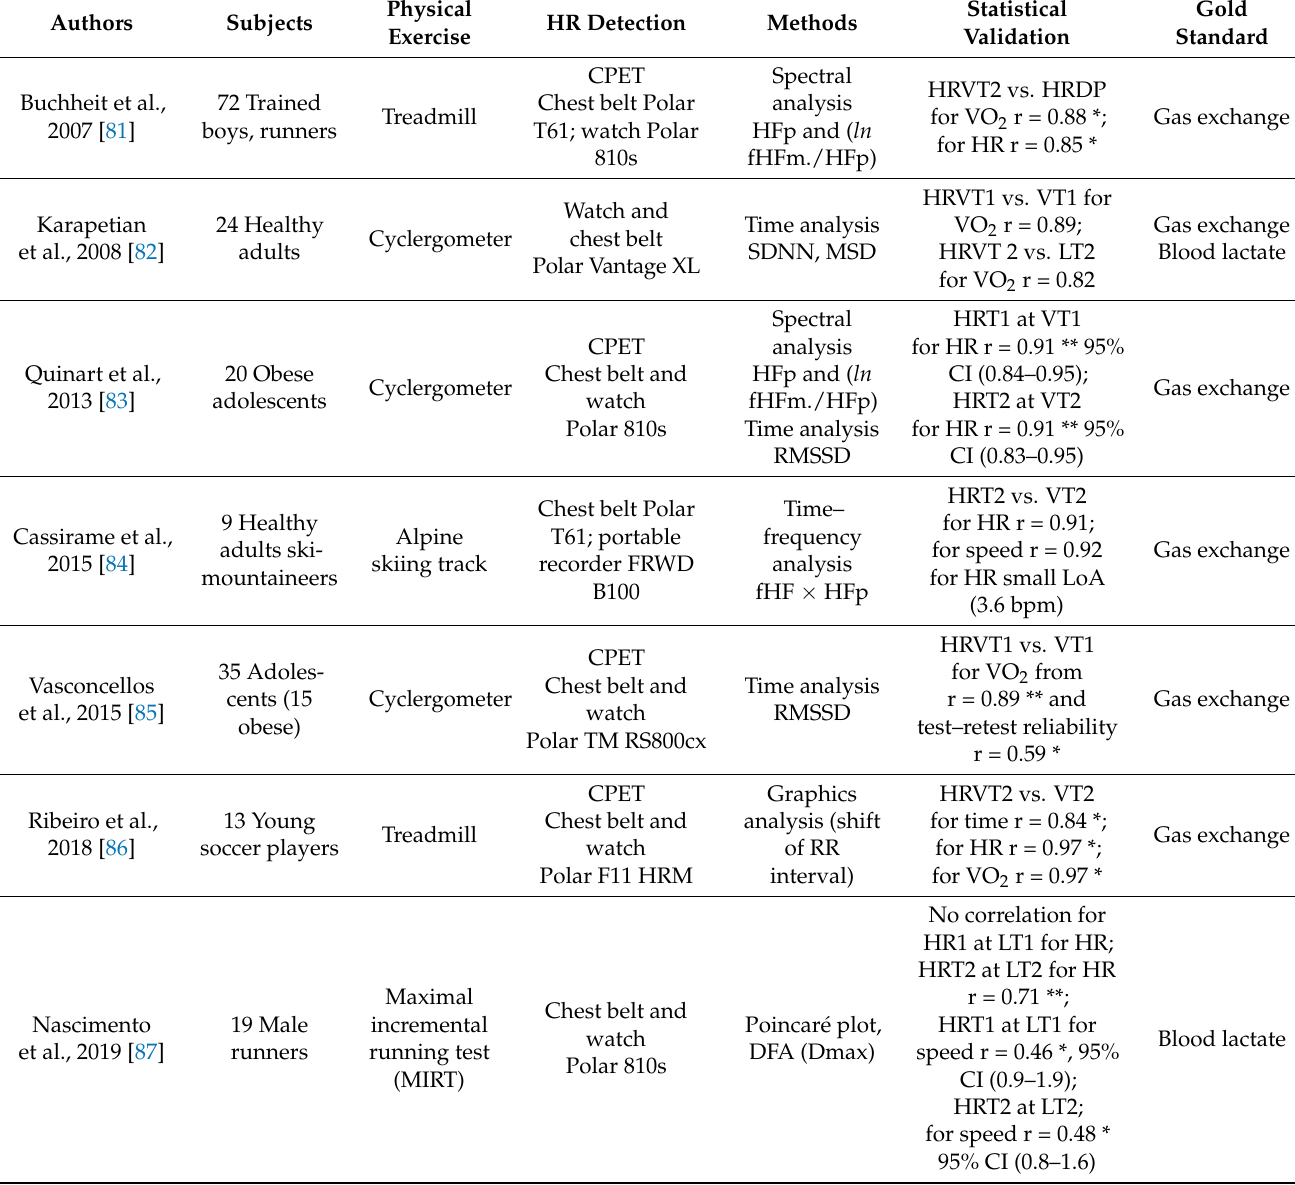
Table 1. HR and metabolic